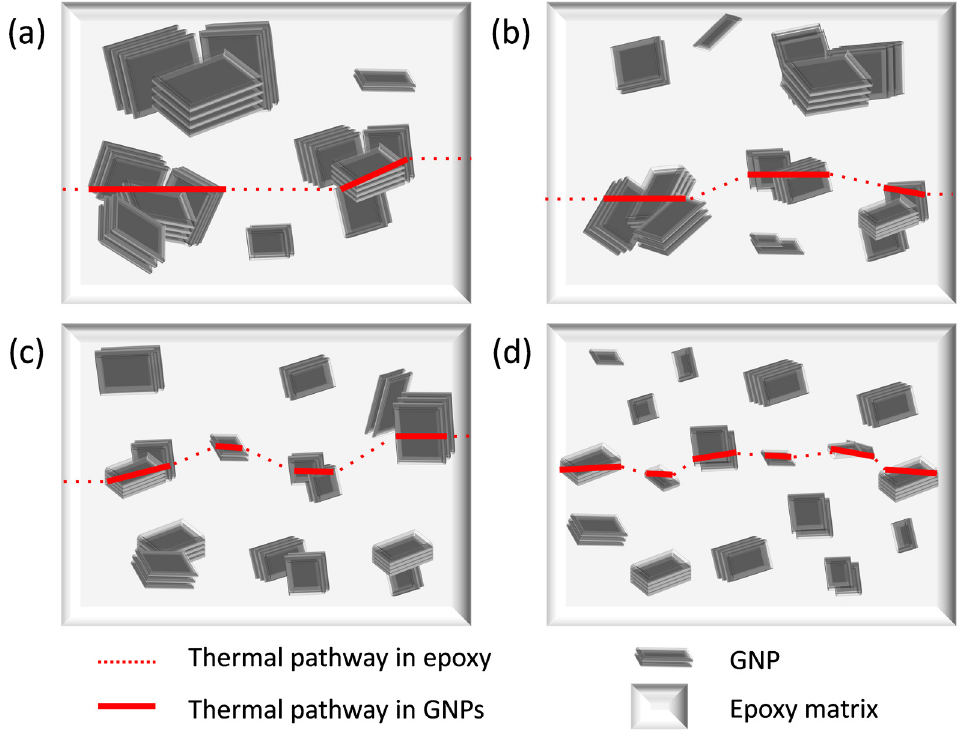
Figure 6. Pathways of thermal conduction for the composites loaded with a low concentration (ca. 0.3 wt.%) of ( a ) S2-, ( b ) S4-, ( c ) MS2-, and ( d ) MS4-GNPs.